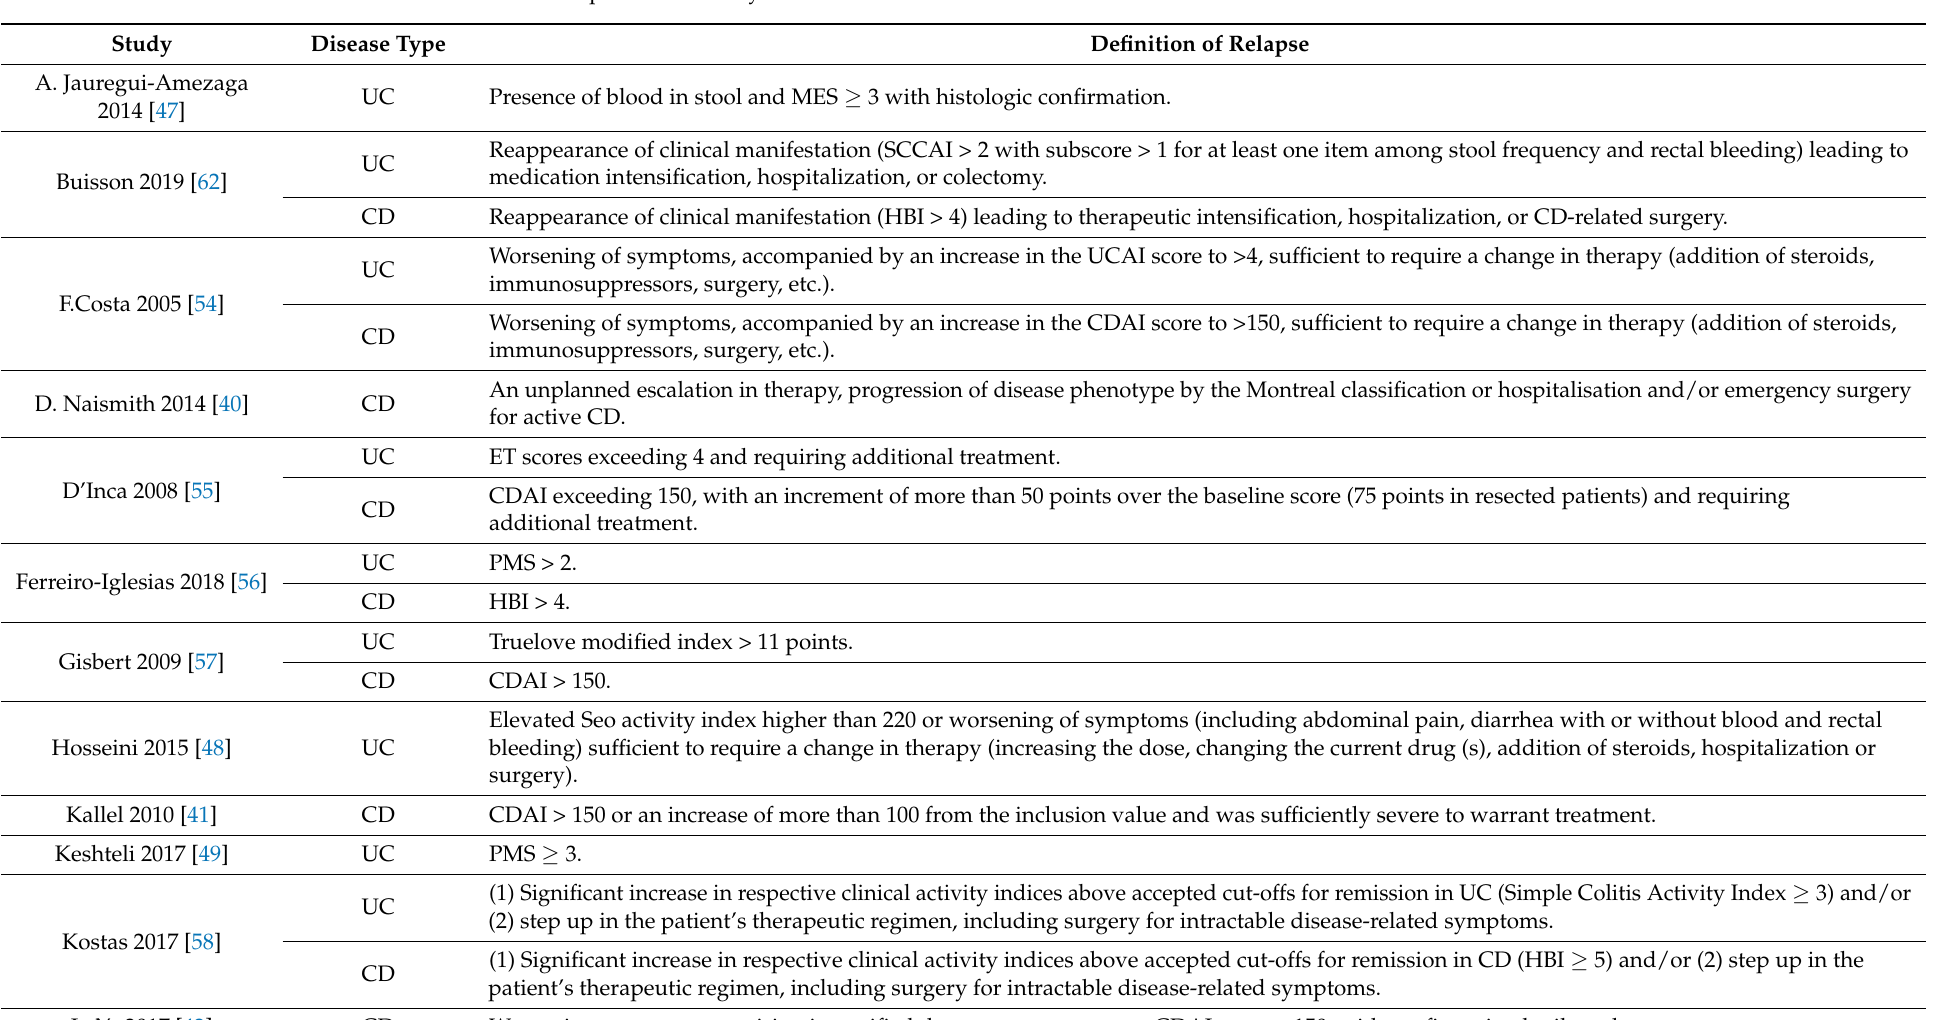
Table 3. Definitions of relapse in each study